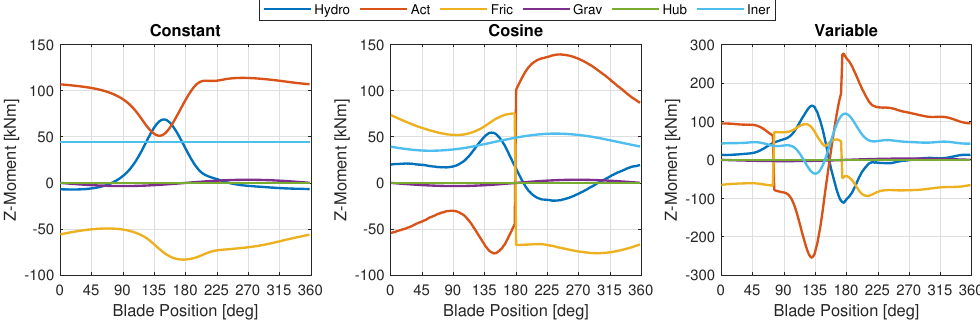
Figure 8. Determined torque components for the propeller blade to pitch according to the pitch trajectories. The results for each pitch trajectory are shown in each of the plots according to their